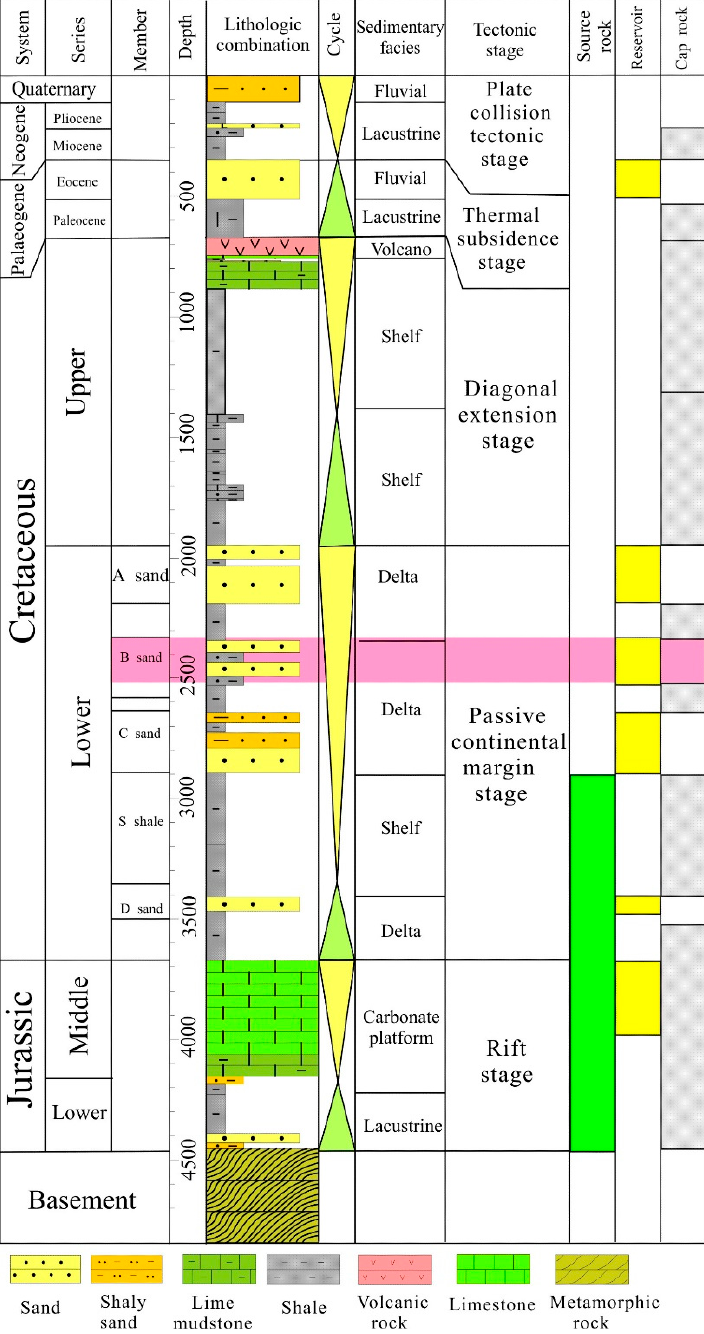
Figure 2. General stratigraphy, lithology and tectonic evolution of the study area